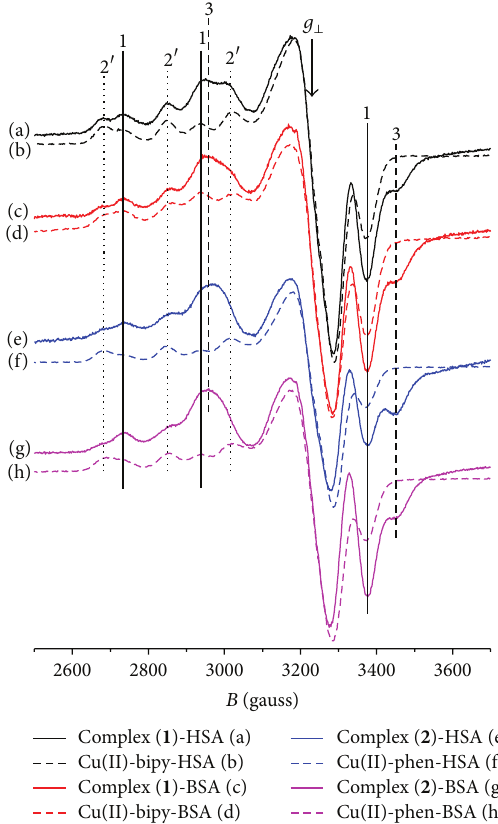
Figure 7: X-band EPR spectra for complexes 1 , Cu(II)-bipy, 2, and Cu(II)-phenwithequimolaramountsofHSAorBSA(concentration of the complexes: 0.5 mM, phosphate buffer 20 mM, pH 7.4, and temperature 77K). (a) 1 :HSA; (b) Cu(II)-bipy:HSA; (c) 1 :BSA; (d) Cu(II)-bipy:BSA; (e) 2 :HSA; (f) Cu(II)-phen:HSA; (g) 2 :BSA; (h)